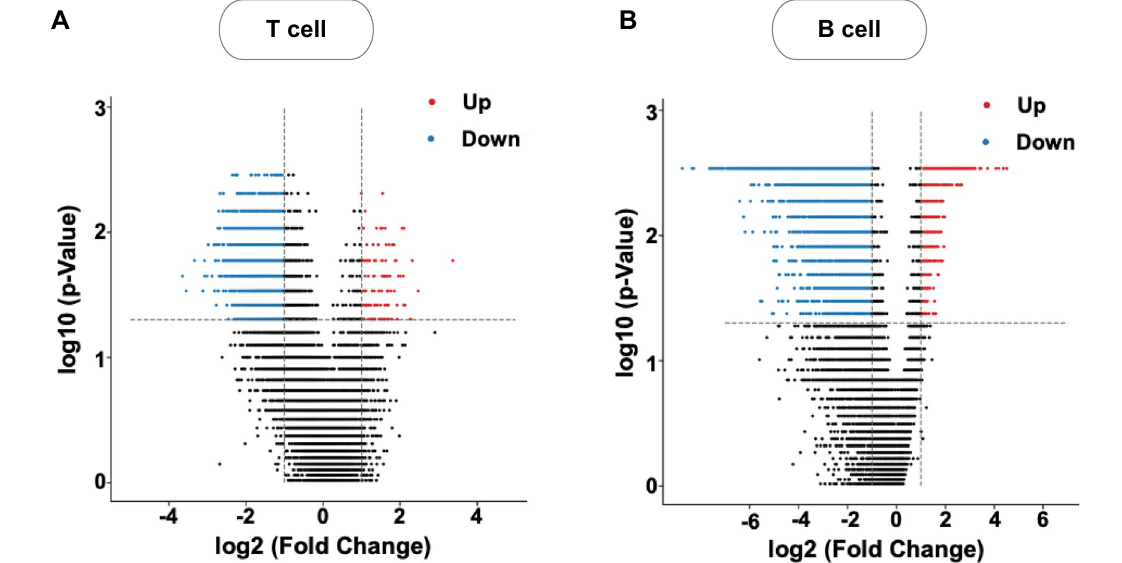
Figure 5. Volcano plots summarizing the comparison of the splicing ratio of individual intron between SLE patients and control samples in T cells ( A ) and B cells ( B ). Fold change of splicing ratio between SLE and control samples was computed and displayed along the x-axis in Log2 scale. Permutation-based p values on the significance of fold change were computed via Mann–Whitney U test and displayed along the y-axis in Log10 scale using 14 SLE versus 4 control samples for T cell and 16 SLE versus. 4 control samples for B cells. Each dot is for one intron. Those introns with |Fo\ldChange|≥ 2.0 (x-axis) and p value ≤ 0.05 (y-axis), i.e., those with significantly altered splicing ratio, were color coded with red for up-regulated (SLE vs. control samples) and blue for down-regulated. Specifically, for T cells in ( A ), there were 5356 blue dots (from 2617 unique genes) and 120 red dots (from 106 unique genes) out of 30,319 dots in total; and for B cells in ( B ), 5754 blue dots (from 2839 unique genes) and 533 introns (414 unique genes) out of 11,114